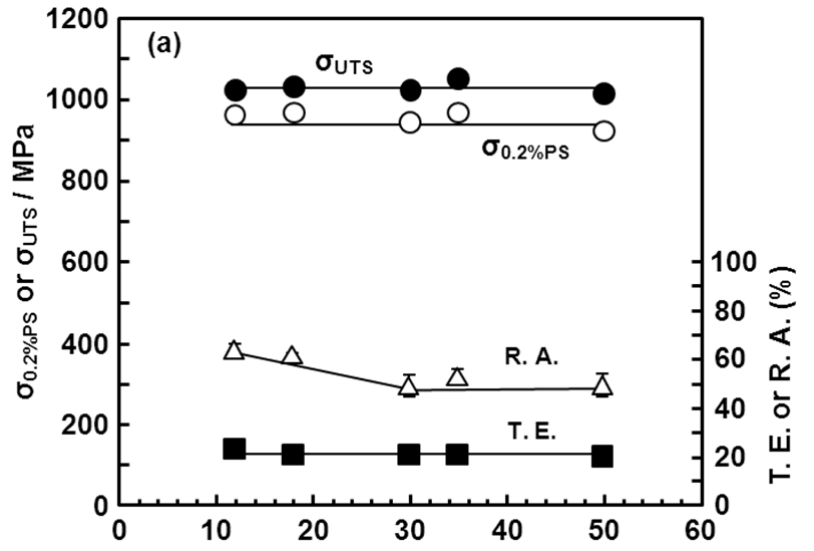
Figure 19. Effects of rolling diameter on mechanical properties ( σ R.A.) and Hv of hot-rolled Ti-15Zr-4Nb-4Ta alloy